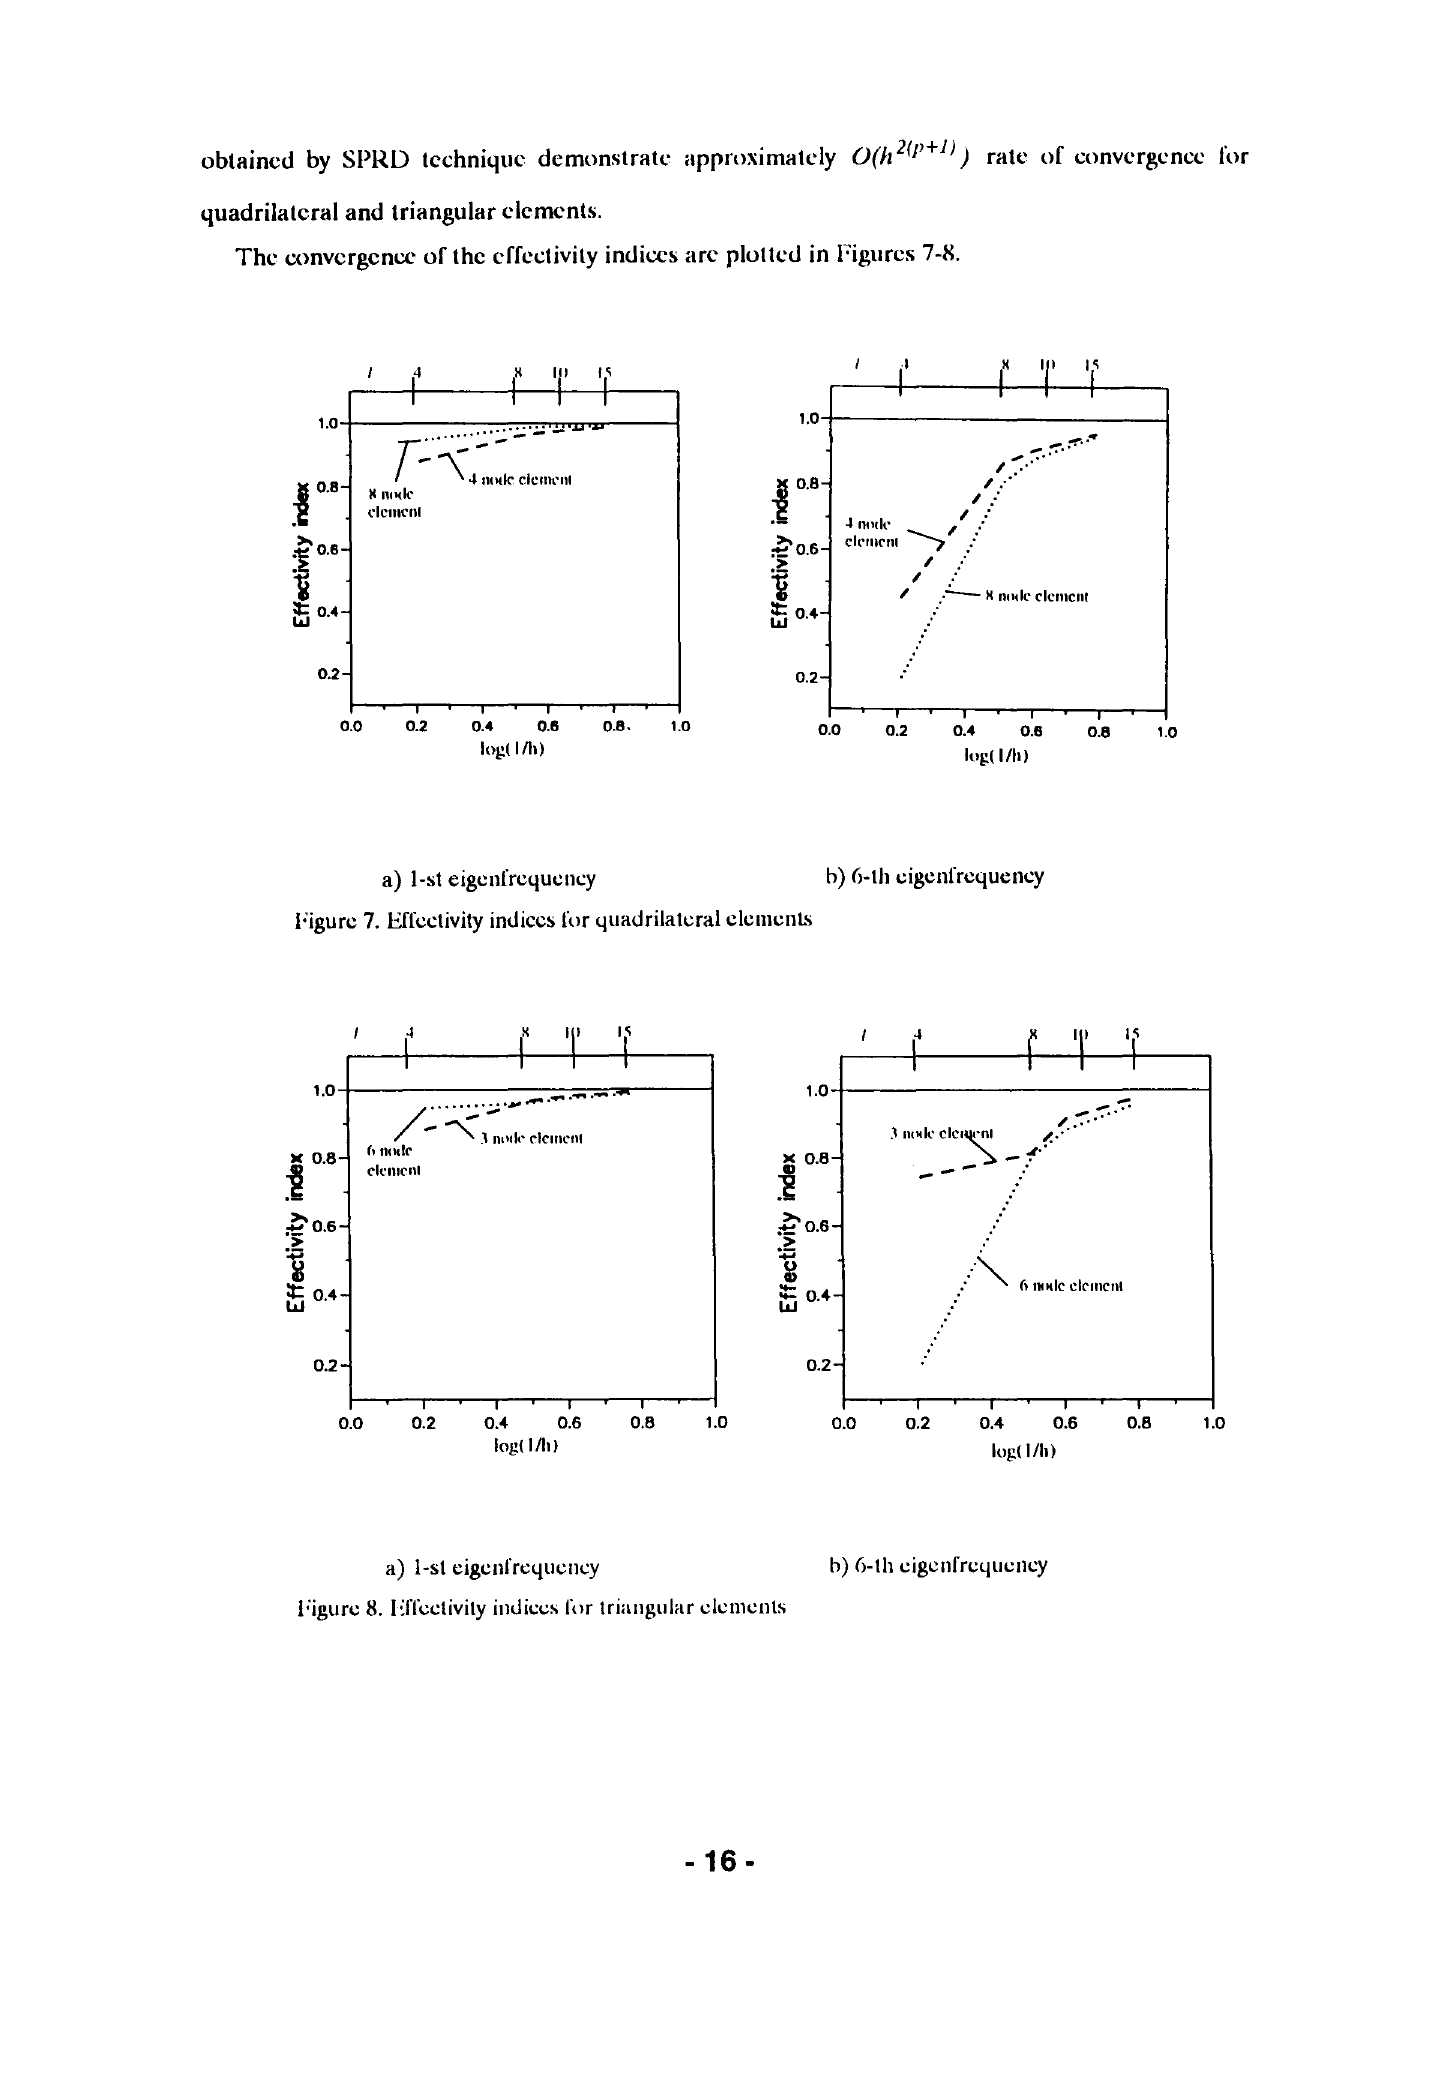
Figure 8. ElT...:ctivity indi...:...:s for triangular